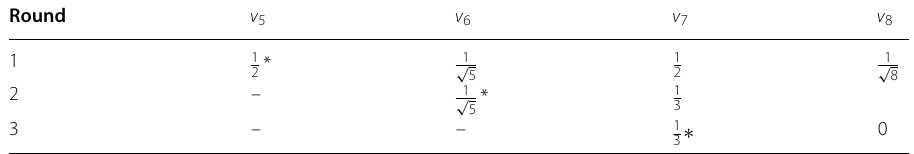
Table 5 Running process of divide-and-conquer algorithm